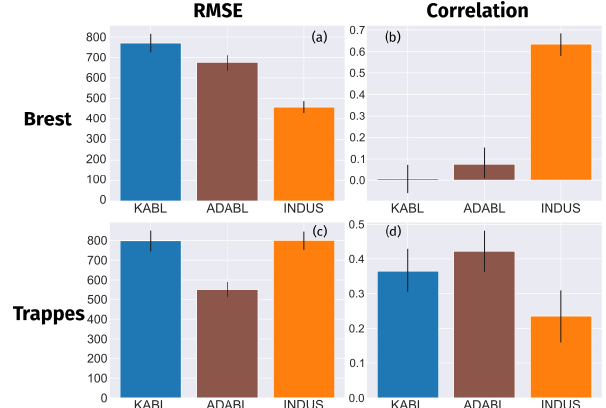
Figure 9. Results of a 2-year comparison with the radiosonde (RS) estimates at both sites for two metrics: RMSE and correlation. IN- DUS refers to the manufacturer’s algorithm; KABL and ADABL refer to the eponymous estimates. Cases at night or with rain, fog, an RS-estimated boundary layer height (BLH) of under 120m, or clouds under 3000m were removed. The 95% confidence intervals were estimated using percentile bootstrapping (Davison and Hink- ley,